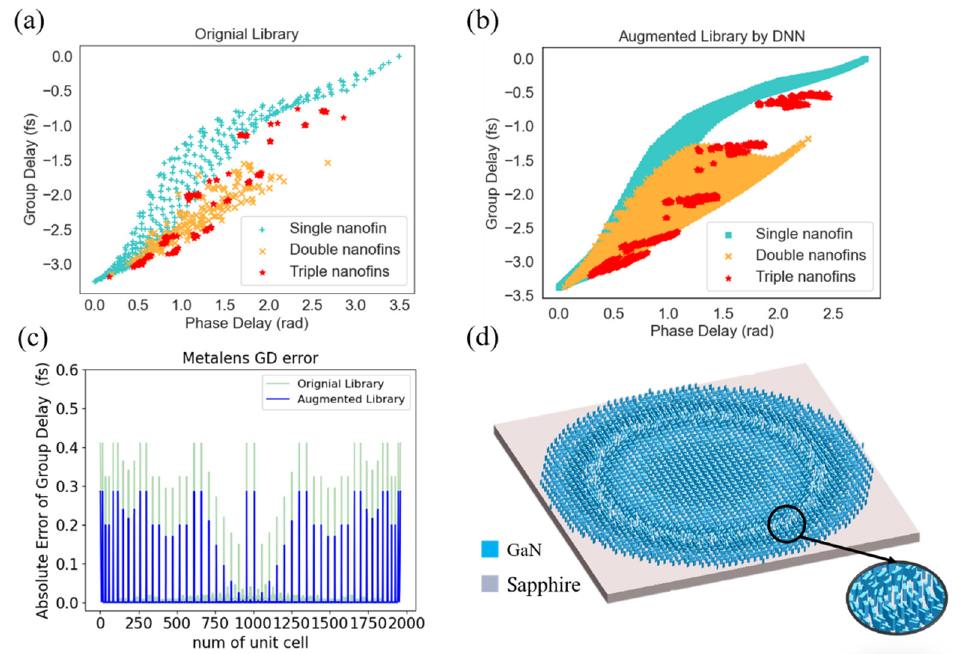
Figure 4. The data and absolute error of original and augmented library and the designed broadband achromatic metalens schematic. ( a ) The FDTD simulation calculated the original data library (one thousand points). ( b ) The augmented data library (ten thousand points) predicted by the DNN model. ( c ) A comparison between the group delay error selected from the original and augmented library. The horizontal axis is the unit cell on the metalens. ( d ) Schematic of the broadband achromatic metalens constructed by the augmented library. The materials of substrate and nanostructures are sapphire and GaN, respectively.